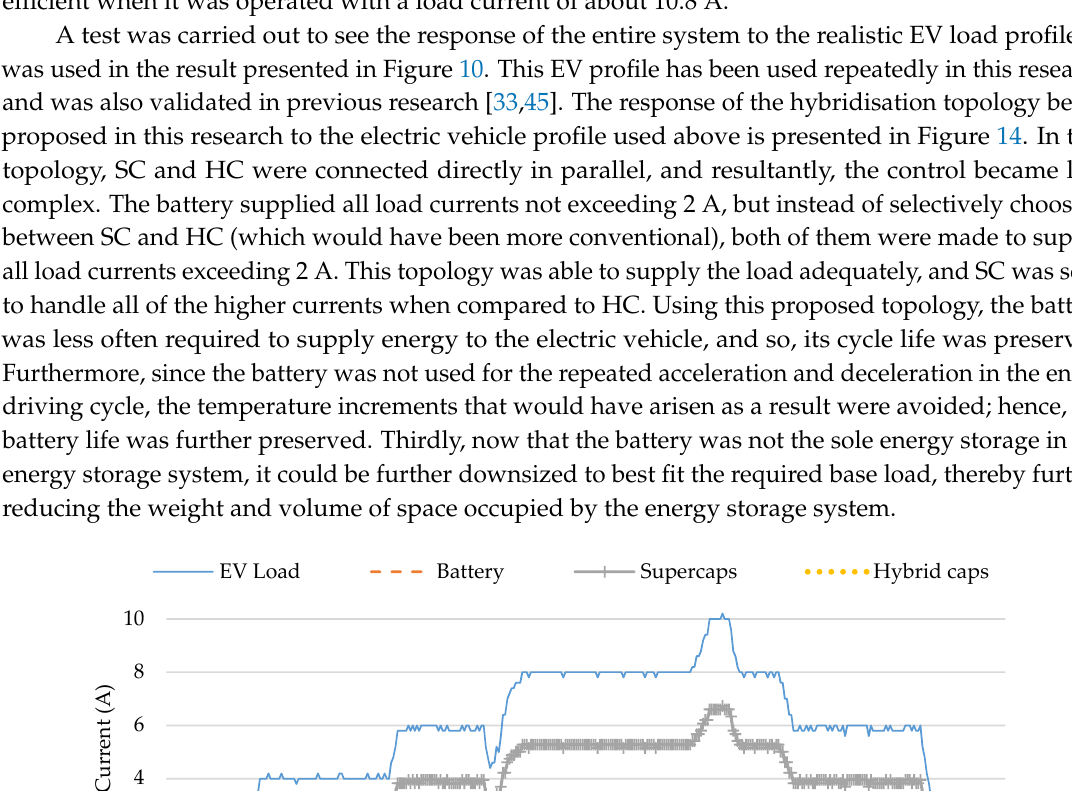
Figure 13. The efficiency results of the multiple input converter operating in Modes A and B ( a ) under varying duty cycles at a constant load and ( b ) under varying load currents at a constant output voltage.